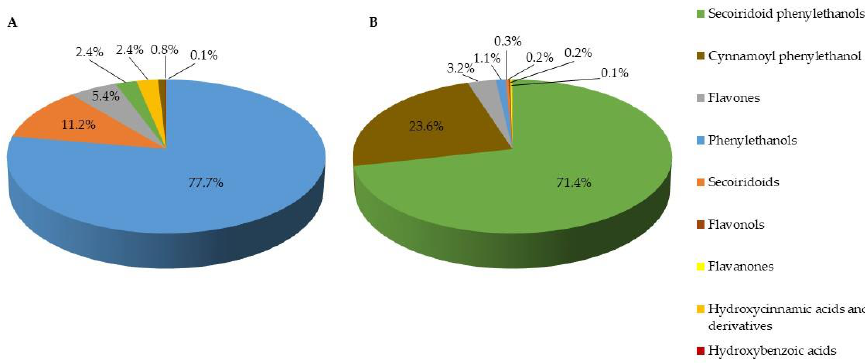
Figure 1. Phenolic and secoiridoid composition of olive-leaf extracts E1 ( A ) and E2 ( B ). Table 2. Quantification of main phenolic and secoiridoid compounds present in olive-leaf extracts (E1 and E2). Results are expressed as mean value ± standard deviation for dry matter (mg/100 g).